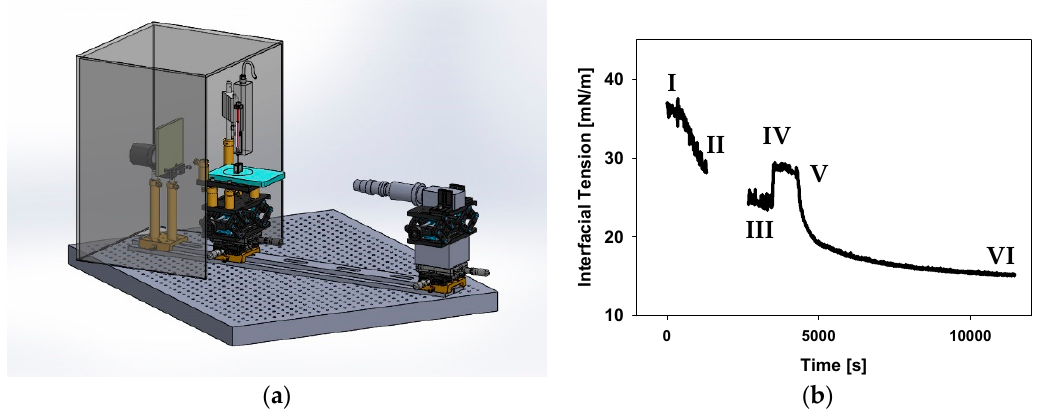
Figure 1. ( a ) Model of the pendant drop tensiometer setup used for all data collection. ( b ) Typical data for a full lipid adsorption, expansion of lipid monolayer, and interaction with protein experiment. In I, a 5 μ L triolein drop in buffer is formed and left to equilibrate. During time II, a 1-palmitoyl-2-oleoyl-sn-glycero-3-phosphocholine (POPC) monolayer is formed. The gap in data between II and III indicates the time where residual vesicles are removed. At III, the lipid monolayer is expanded by increasing the oil drop volume. In IV, the expanded drop monolayer was left to equilibrate and then protein (either full-length or C-terminal construct) was added and allowed to insert V-VI.